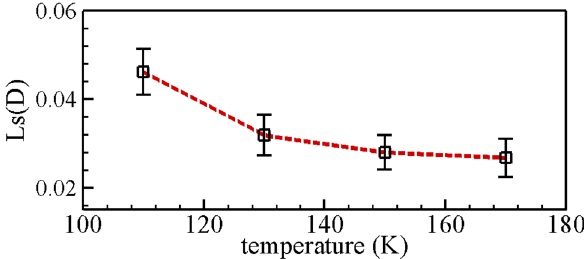
Figure 7. Slip lengths L S ( D ) of methane nanofluidic near rough boundary and calculation errors by the presented model. The red dashed curves are guide.